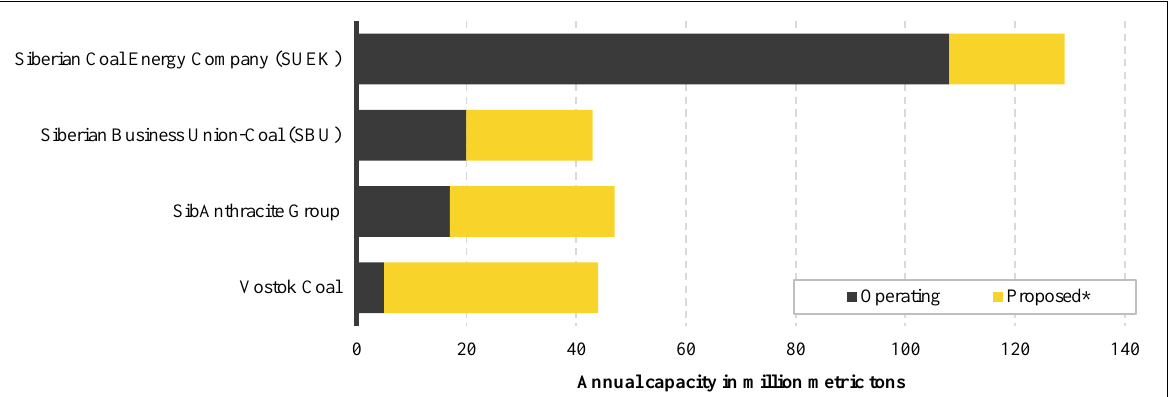
Figure 3. Annual capacity of coal mines in Russia